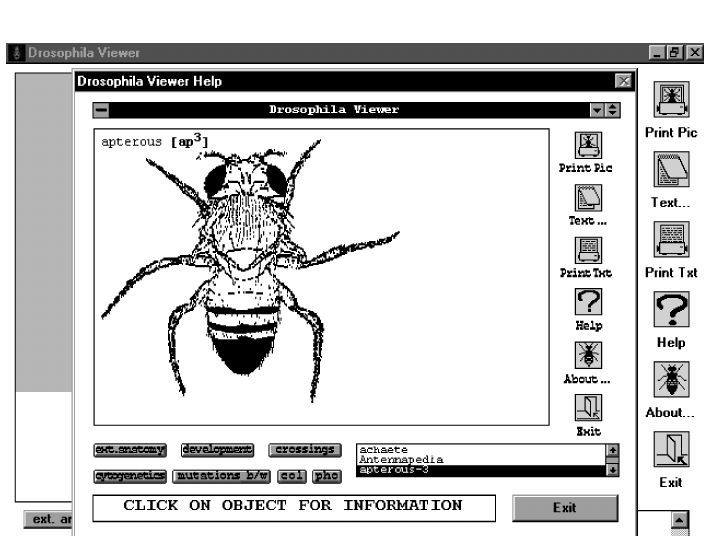
Figure 2 - Main graphic interface of the program, before the options given by the command buttons at the bottom and pic- tures on the right are chosen.